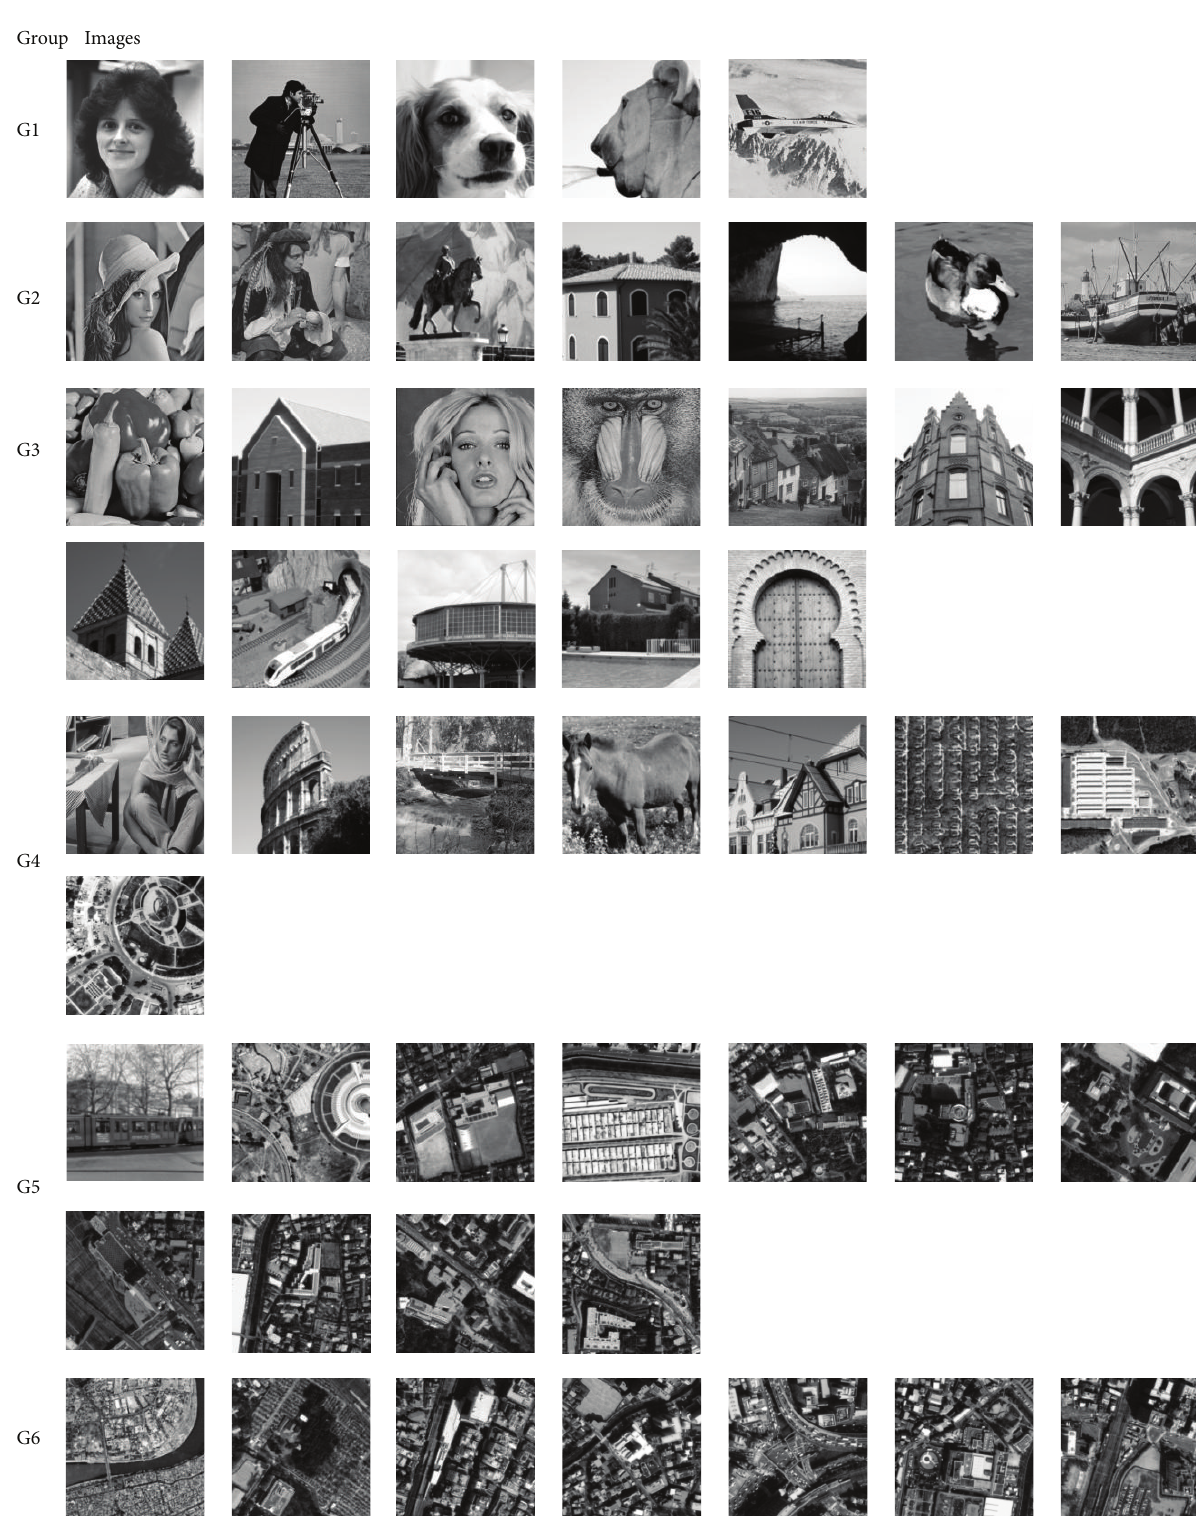
Figure 9: Group of classified